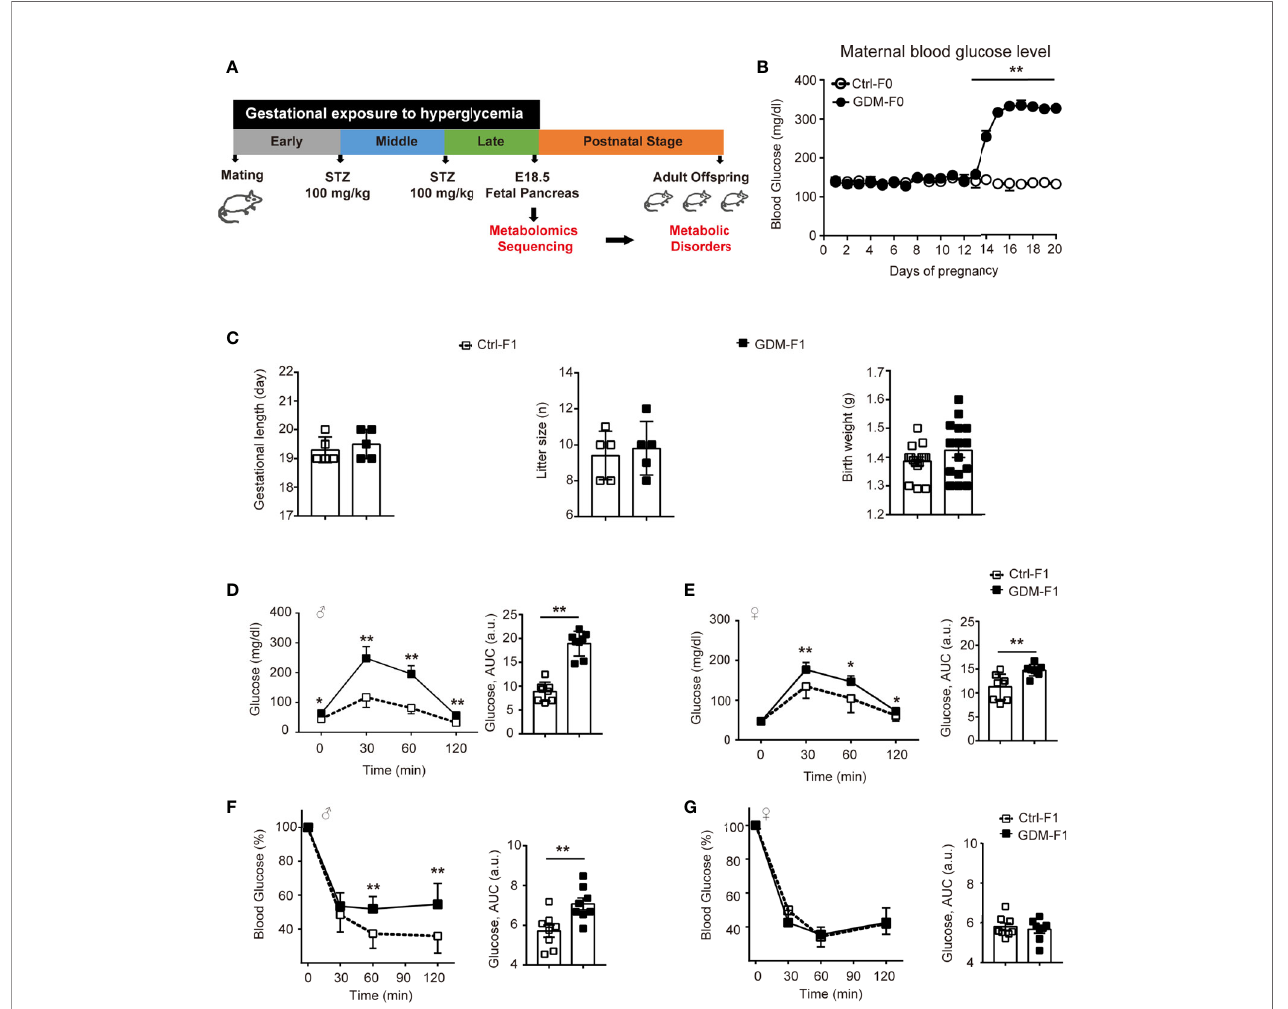
FIGURE 1 | Experimental design, glucose, and insulin tolerance. (A) Experimental design. (B) Maternal blood glucose level during pregnancy (n = 5 mice per group). (C) Gestational length, litter size in F0 mice, and birth weight in F1 mice (n=5 mice per F0 group, n=15 mice per F1 group). (D) Glucose tolerance test and AUC of 8- week-old male F1 offspring (n =8 per group). (E) Glucose tolerance test and AUC of 8-week-old female F1 offspring (n =8 per group) (F) Insulin tolerance test and AUC of 8-week-old male F1 offspring (n =8 per group). (G) Insulin tolerance test and AUC of 8-week-old female F1 offspring (n =8 per group). All data were expressed as mean ± S.D. * P < 0.05 vs. Ctrl-F1; ** P < 0.01 vs.